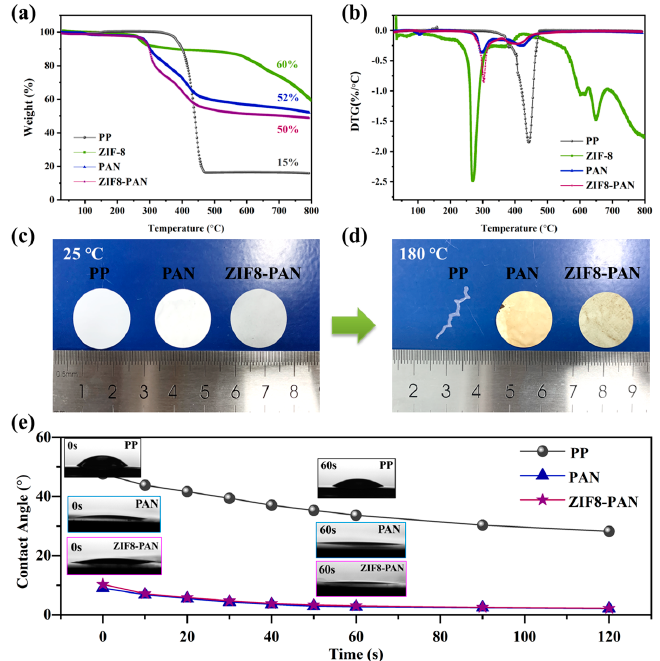
Figure 3. The results of ( a ) TGA; ( b ) DTG measurement of ZIF-8 powder and three kinds of sepa- rators. The comparison of ( c , d ) heat shrinkage tests; ( e ) electrolyte contact angle of PP, PAN and ZIF8-PAN separators.